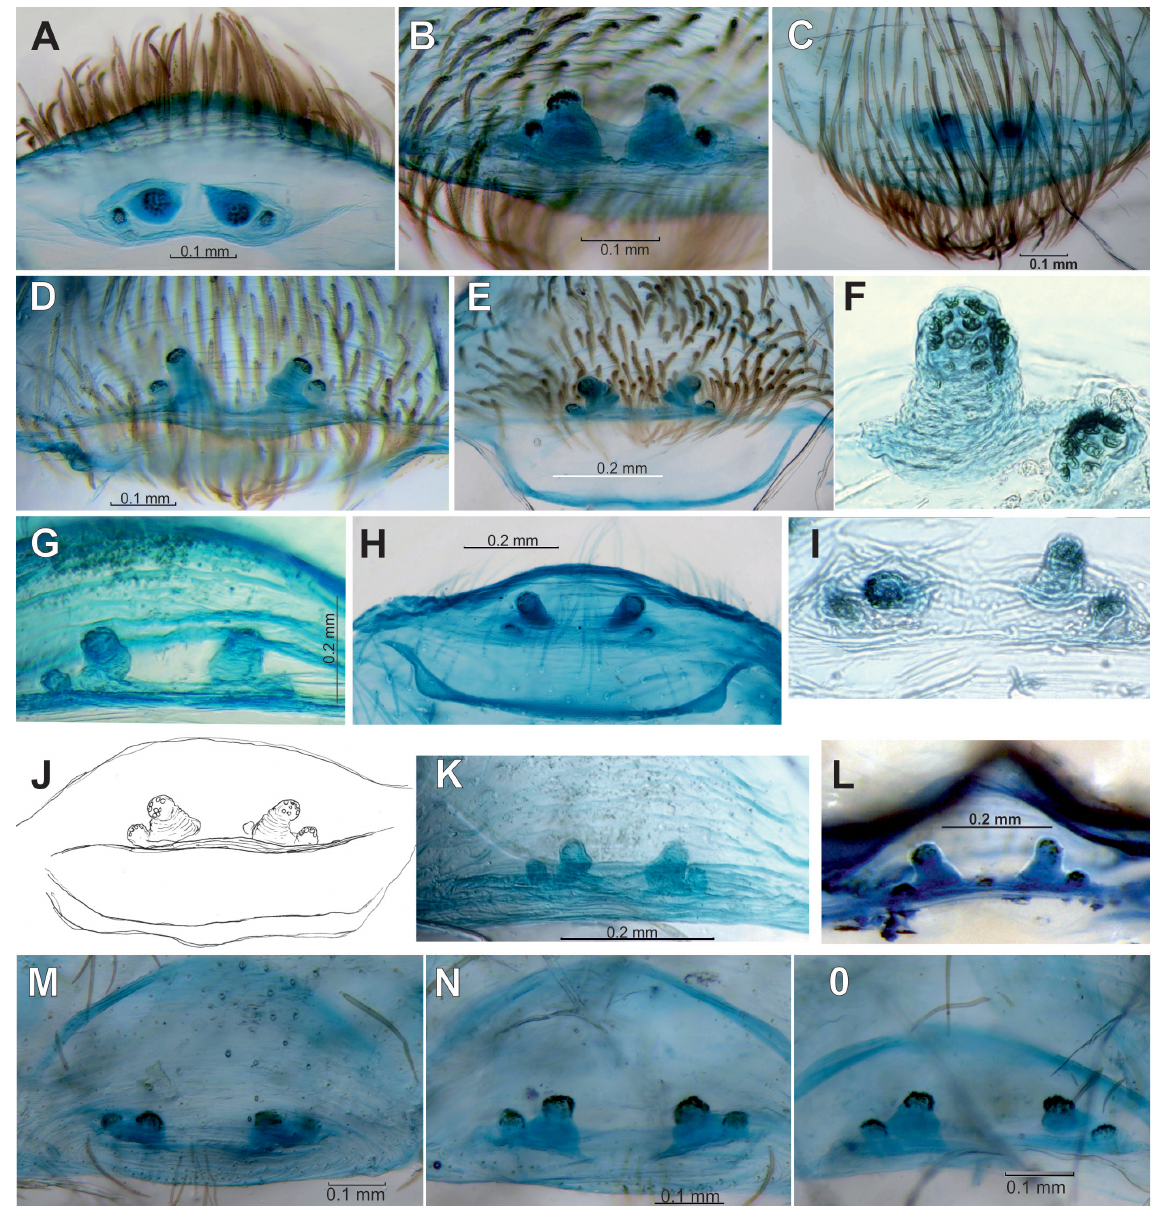
Fig. 26. Zaitunia martynovae (Andreeva & Tyshchenko, 1969), structure of endogyne in ♀♀ from Gandzhina ( A – C , J ), Kopetdagh ( D–E ), Babatagh ( F – I , K–L ) and Pyandzh Karatau ( M – O ). — A , I . endogynal plate from above. B , D , L , N – O . endogyne, dorsal. C , M . endogyne, ventral. E , G , H , J–K . endogyne, dorsal-anterior. F . right pair of receptacles,